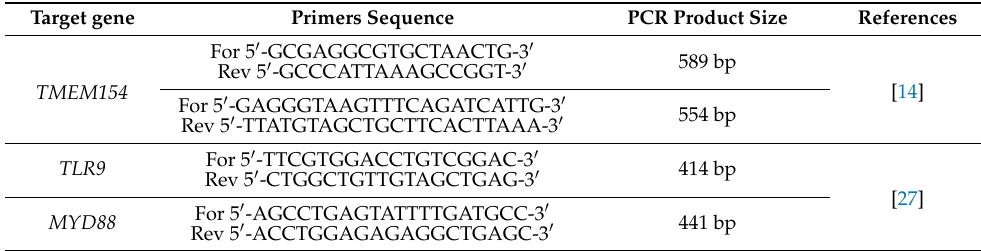
Table 1. Primer sequences of target genes. Target gene Primers Sequence PCR Product